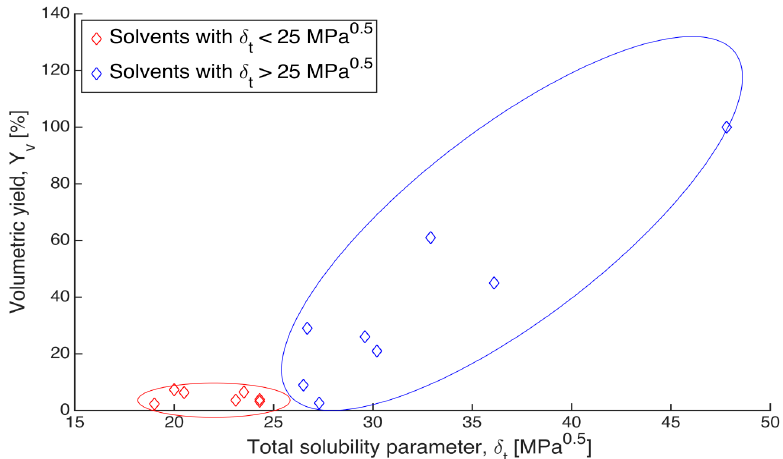
) of gels after solvent exchange and (cid:3049),(cid:2869)